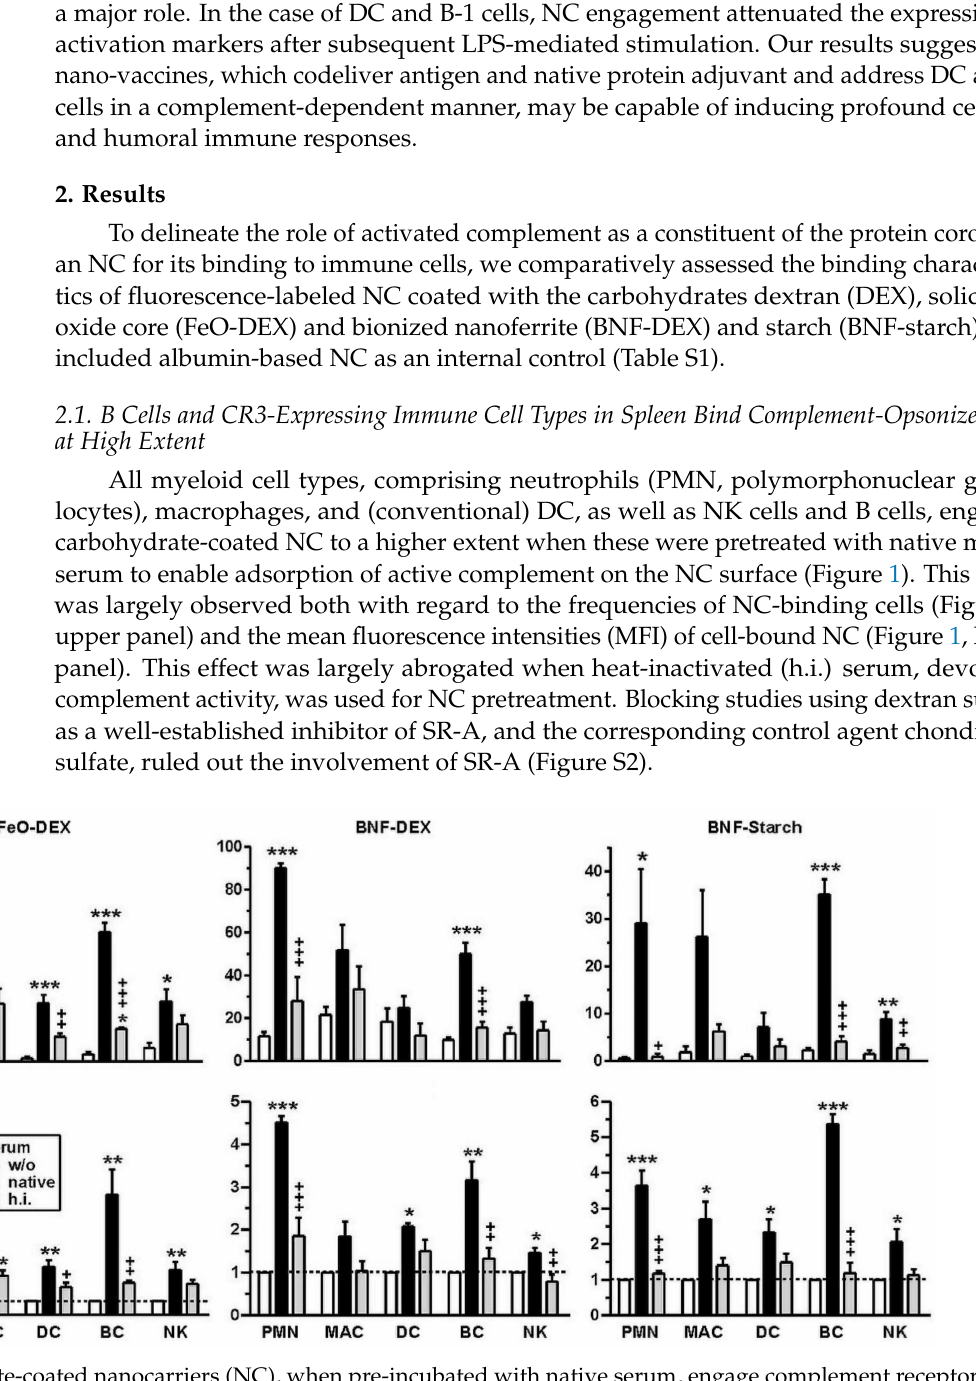
Figure 1. Carbohydrate-coated nanocarriers (NC), when pre-incubated with native serum, engage complement receptor- expressing splenic cell populations at a high extent. Spleen cells were incubated for 3 h with differentially pretreated (left untreated (w/o), pretreated with native or heat-inactivated (h.i.) serum) types of carbohydrate-coated NC. NC binding to neutrophils (PMN), macrophages (MAC), DC, B cells (BC) and natural killer cells (NK) was assessed by FACS analysis. Details on the gating strategy are given in Figure S1. Graphs denote the frequencies of NC-positive cells (upper panel) and NC-dependent MFI (lower panel) of various splenic leukocyte populations (mean ± SEM of 3–4 experiments). Statistical differences versus *w/o serum and + native serum are indicated (one-way ANOVA, Tukey’s test). * ,+ p < 0.05, ** ,++ p < 0.01, *** ,+++ p <